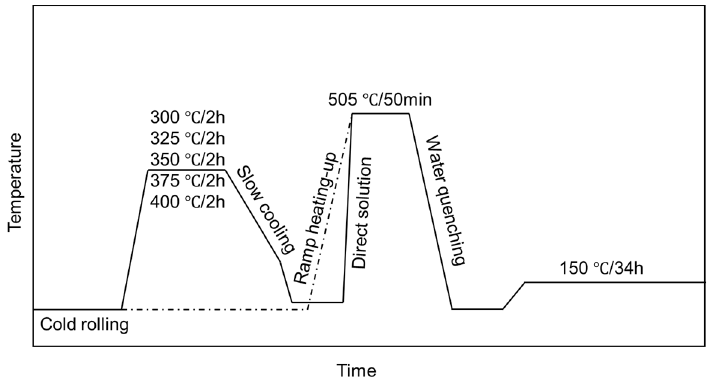
Figure 1. The route of entire process procedures of the Al-Cu-Li alloy in this experiment.